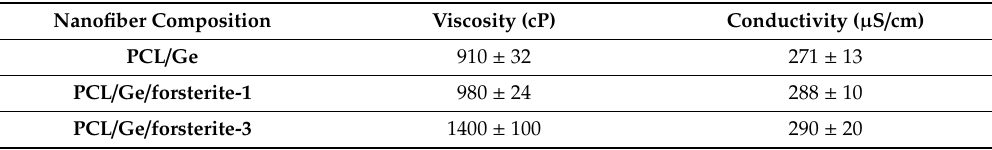
Table 1. Physical properties of the solutions.